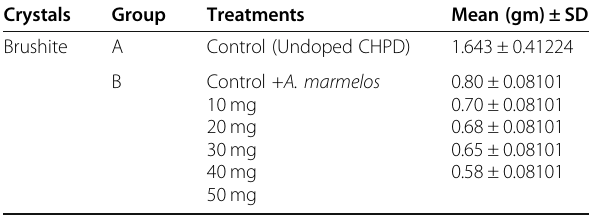
Table 1 ANOVA statistical analysis of CHPD crystals Crystals